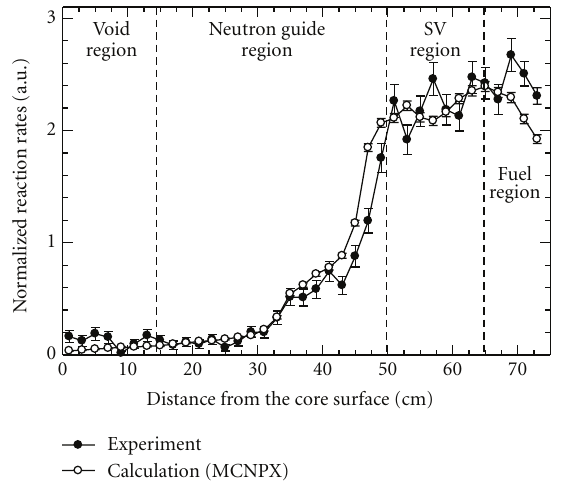
Figure 3: Comparison between the measured and calculated reaction rates of 115 In( n , γ ) 116m In reactions along the region of (13- 14, A–P; Figure 1).